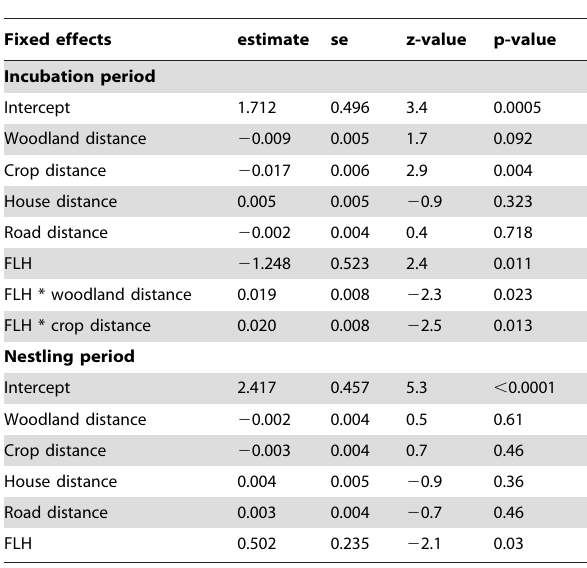
Table 2. Model (binomial GLMM) on nest predation risk during the incubation (n= 923) and nestling period (n=839) in relation to different habitat